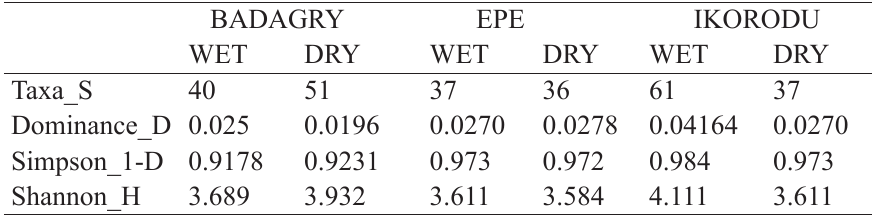
Table 3. Diversity analyses of floral species encountered in each sampling locations during dry and wet